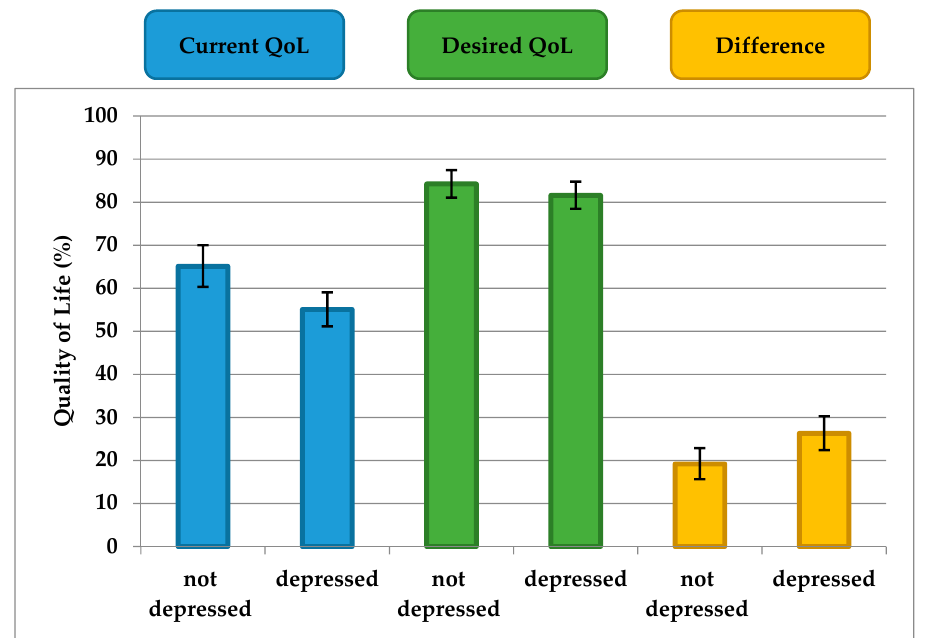
Figure 3. Depression and quality of life in Parkinons’s disease. Mean current quality of life (QoL), desired QoL, and difference between current and desired QoL in patients with Parkinson’s disease (mean and 95%CI).